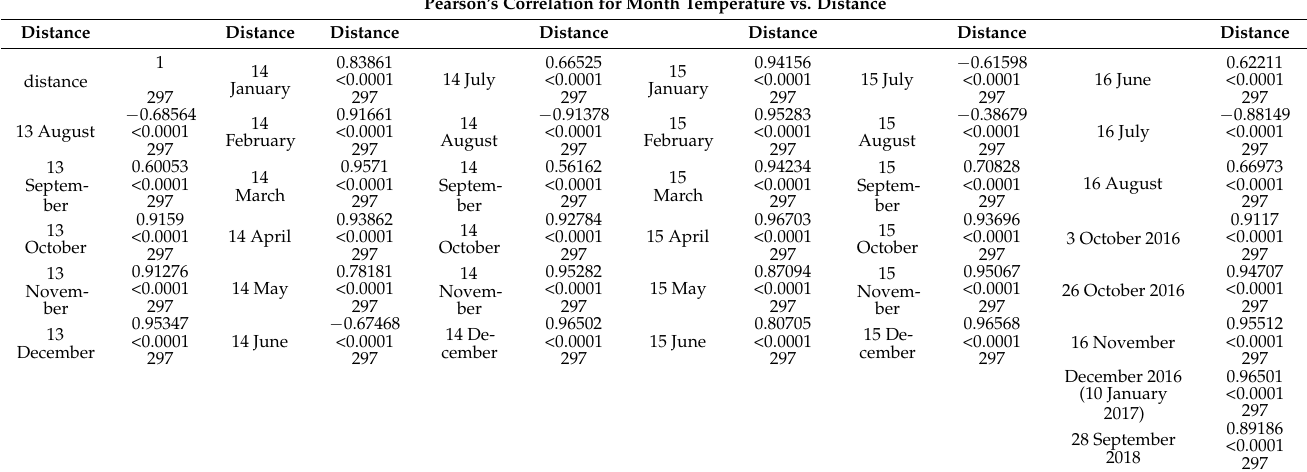
Table 2. Pearson’s correlations analysis between different months of years and increment of depth/distance at Suvilahti, Liito-oravankatu, in the city of Vaasa. The first row shows Pearson’s correlation results, the second row shows statistical significance, and the third row shows the number of samples in each analysis. Pearson’s Correlation for Month Temperature vs.